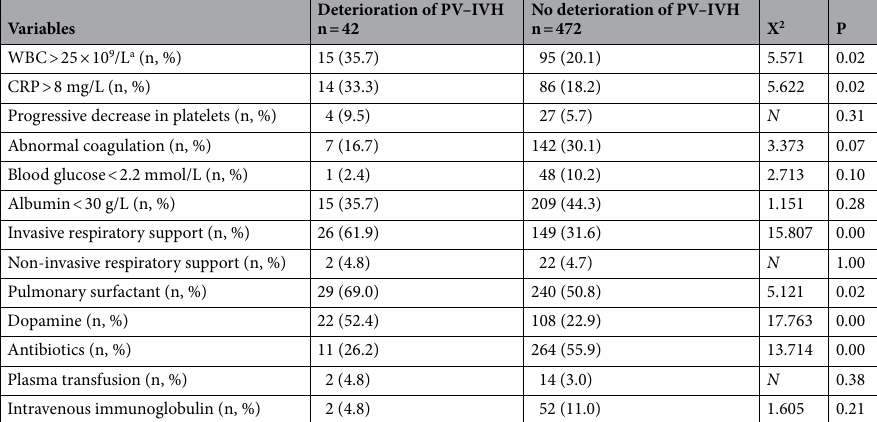
Table 3. Laboratory test and treatment in preterm infants with PV–IVH who deteriorated or not. PV–IVH periventricular–intraventricular hemorrhage, WBC white blood cell, CRP C-reactive protein. a Baseline values were tested before or within PV–IVH diagnosis.